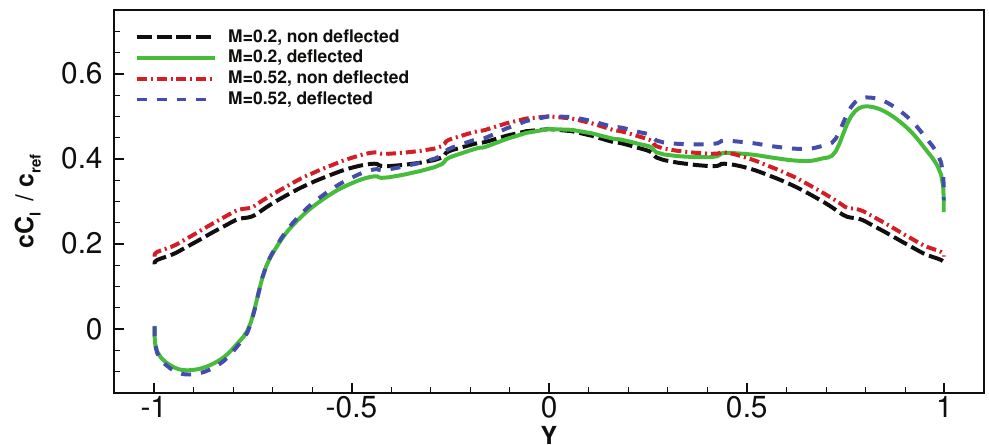
Figure 17. Ailerons: spanwise loading distribution for different flight